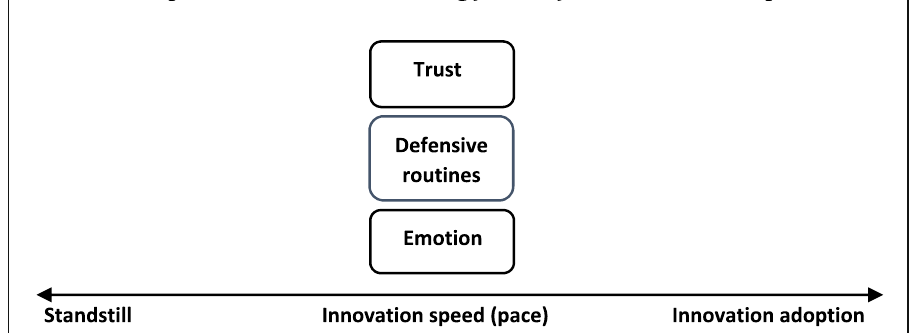
Fig. 1 Innovation speed line with contributing factors for innovation